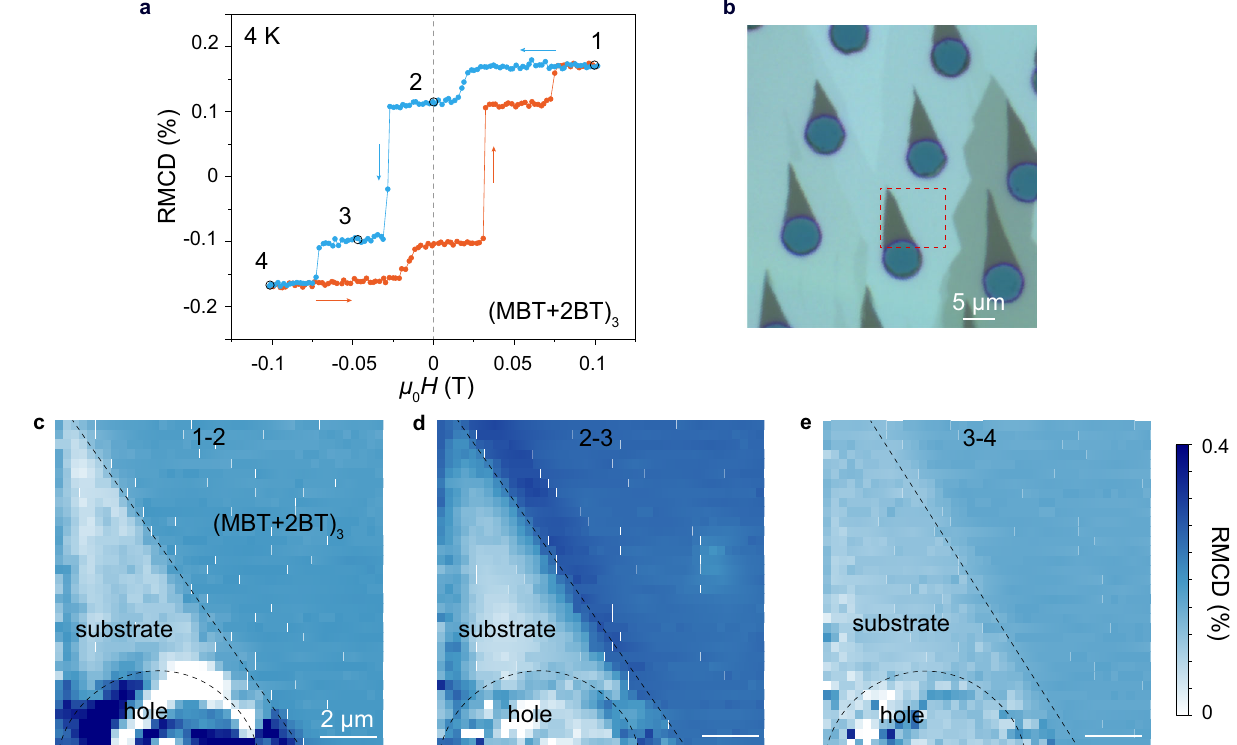
c – e Spatial distributions of the RMCD signal changes in two AFM spin- fl ip transitions (1 – 2 and 3 – 4) and one FM spin- fl ip transition (2 – 3). The homo- geneous signals indicate the uniform FM-AFM coexistence under the experi- mental spatial resolution. The bare substrate and etched hole are marked by black dashed